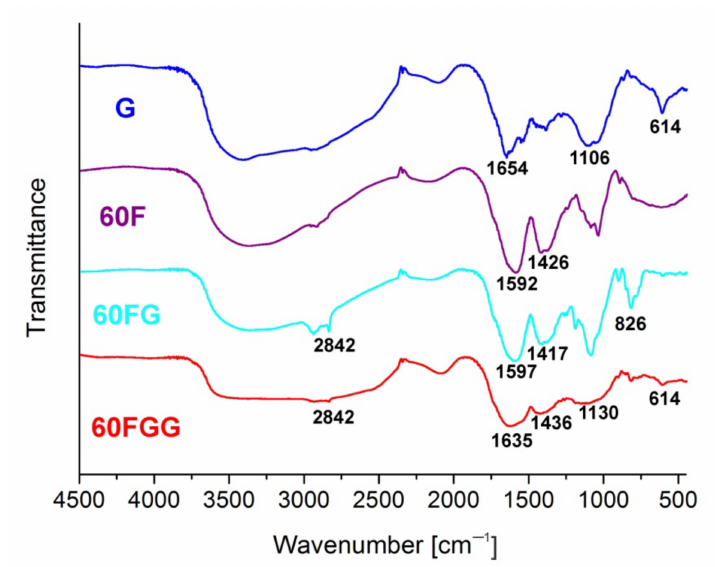
Figure 3. FT-IR spectra recorded in KBr disk for: gentamicin ( G ), fullerenol ( 60F ), GLYMO modified fullerenol ( 60FG ), and gentamicin functionalized C 60 fullerene ( 60FGG